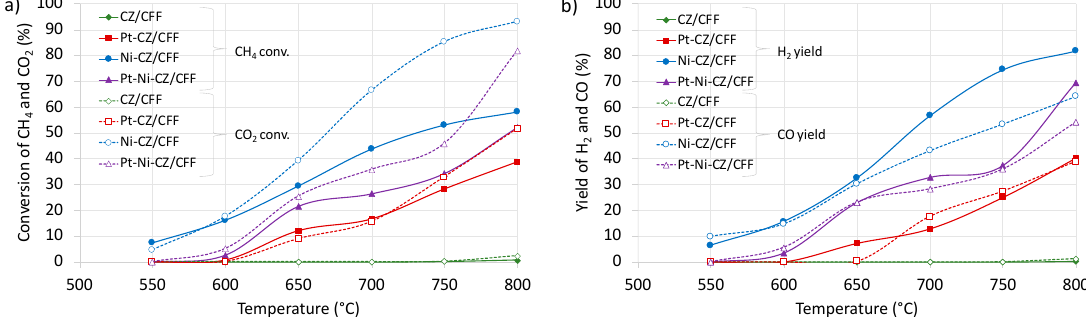
Figure 9. The conversions (conv.) of CH 4 and CO 2 ( a ), and yields of H 2 and CO ( b ) over CZ/CFF, Pt-CZ/CFF, Ni-CZ/CFF, and Pt-Ni-CZ/CFF during catalytic test of DRM in isothermal conditions. Reaction mixture: 4 vol. % CH 4 , 10 vol. % CO 2 , balanced with Ar. GHSV = 5000 h − 1 . Time-on-stream (TOS) = 2 h.